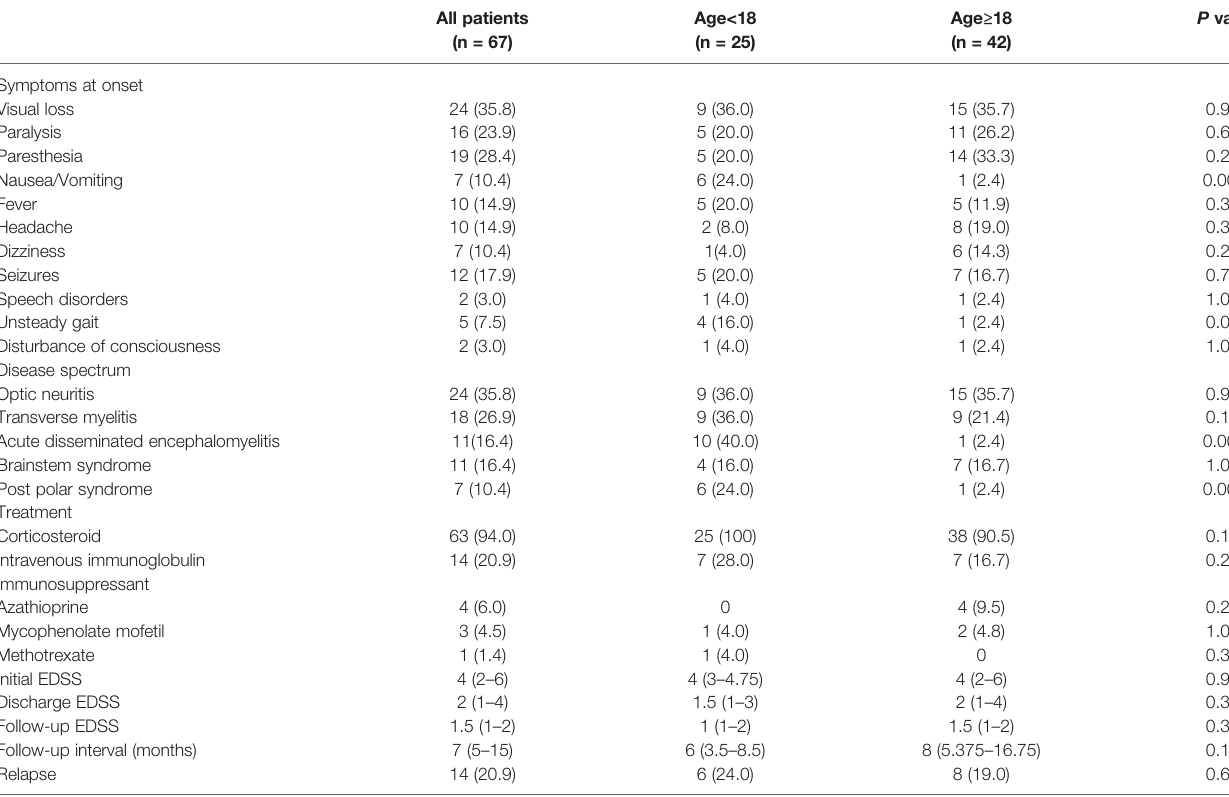
TABLE 2 | Patient characteristics.